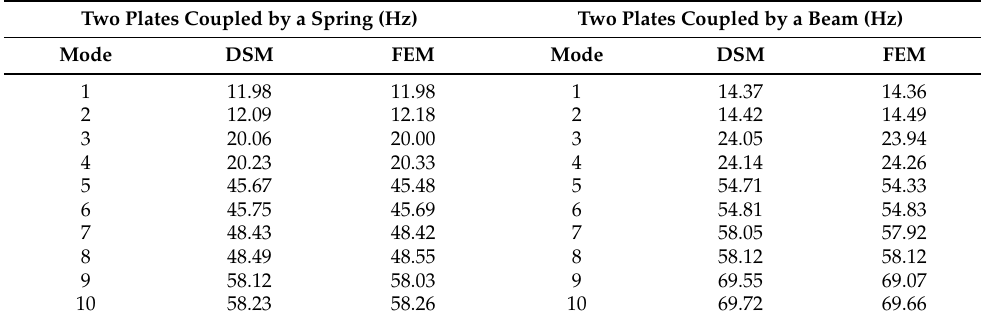
Table 4. The first 10 natural frequencies for two plates coupled by a spring with K s = 1.2 kN/m shown in Figure 17a and by a beam shown in Figure